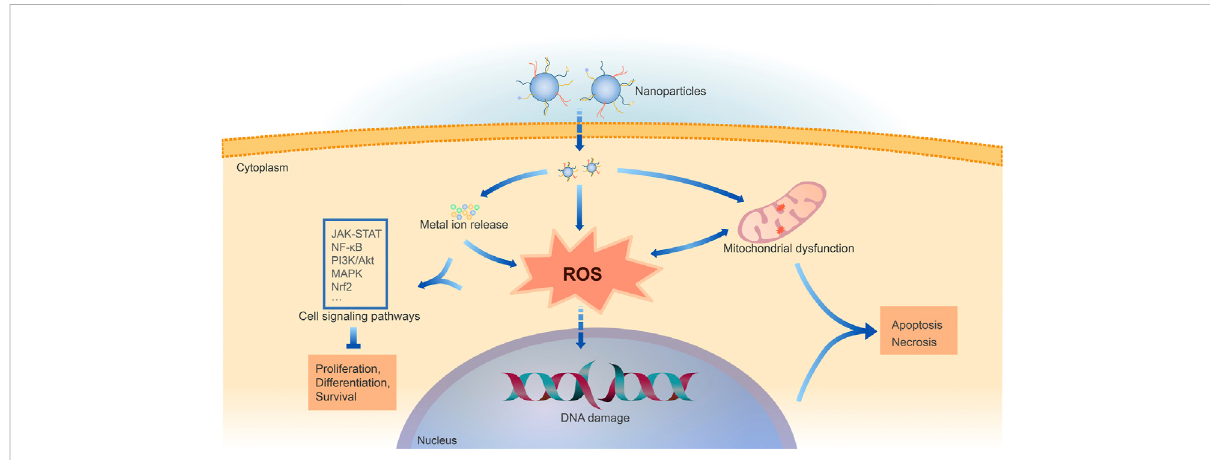
FIGURE 2 Mechanisms of cell damage by metal-based NPs. Following cellular uptake of NPs, metal-based NPs can release intracellular metal ions and induce oxidative stress directly or through mitochondrial dysfunction. ROS generation and consequent oxidative stress are shown to be the fundamental cause of metal-based NP toxicity. The excessive ROS generation and metal ions impact multiple cell signaling pathways, mainly including JAK-STAT, NF- κ B, PI3K/Akt, MAPK, Nrf2. ROS can also cause DNA damage. Thus, it hinders cell physiological processes like proliferation and differentiation, eventually leading to cell apoptosis or